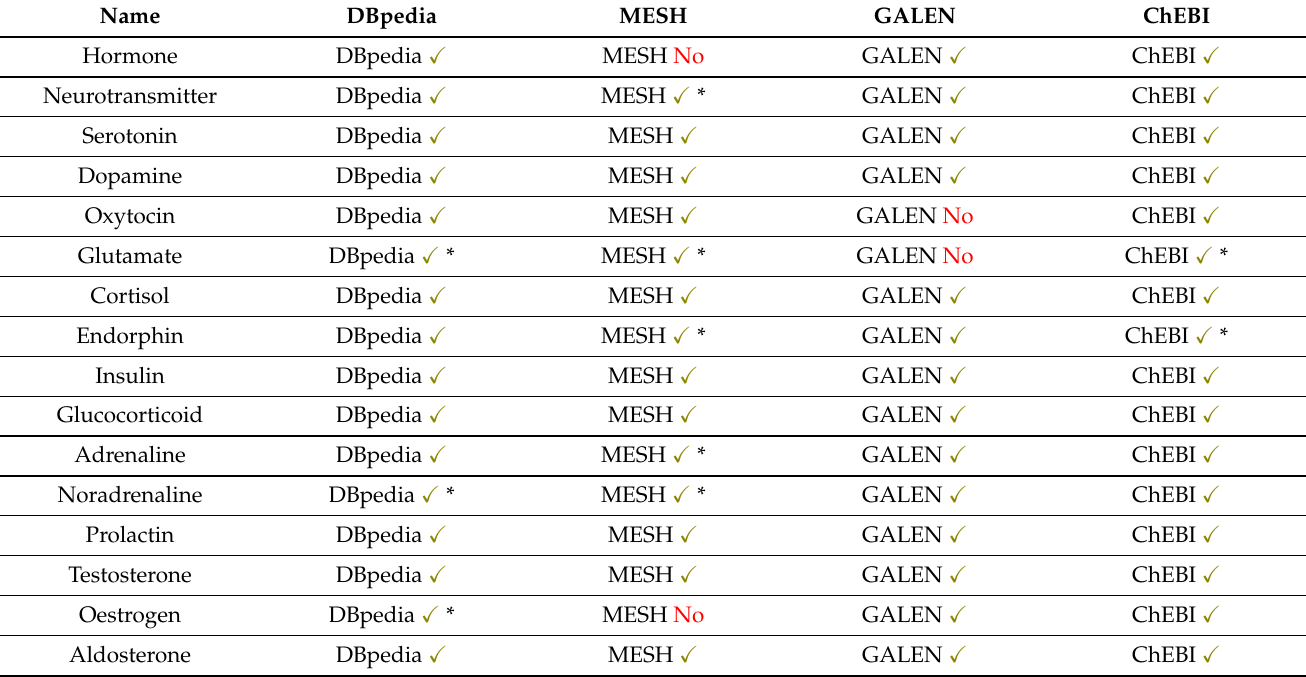
Table 3. Subset of mapping hormones and neurotransmitters to existing knowledge bases to demon- strate the difficulty to reuse only one knowledge base. Legend: * means that we use rdfs:seeAlso since the concepts are similar but might not be an equivalent